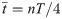
Plots of the time dependent ratios of total numbers of particles found within recirculation regions (depicted in red in inset to figure (a)) of wave-sections W−2 and W2 to the total numbers of particles found in the rest of the tube section. The values are results of volume integrals taken over the axisymmetric tube. The geometric conditions are B = 0.2 and A = 0.48 (which results in fluid recirculation), with transport conditions for (a) of α = 0.1 and β = 0 (solid blue line), β = 200 (pink solid line and triangles) and β = 300 (black solid line and crosses). Data points are at quarter periods of the pressure oscillation, t¯=nT/4 for n = 0, 1, 2, …, although symbols for odd numbered quarter periods have been removed for clarity of presentation. The inset to (b) shows one pressure oscillation with an indication of where data points are taken. In (b) we show the β = 200 results for wave-section k = 2 (pink solid line and triangles) and wave-section k = −2 (green solid line and crosses). For comparison, the red dashed lines depict the ratio of the volumes of the abovementioned regions.